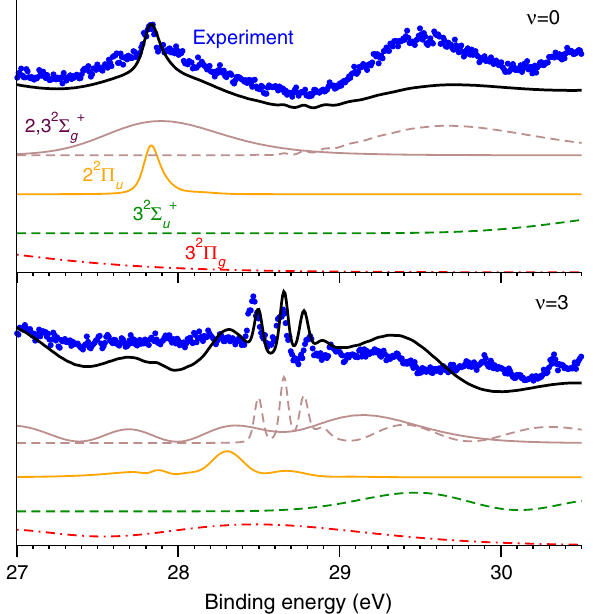
FIG. 7. The details of the experimental and theoretical RPE spectra (see Fig. 4) in the binding-energy range of 27–30 eV. The excitation energies and line notations are the same as in Fig. 5.